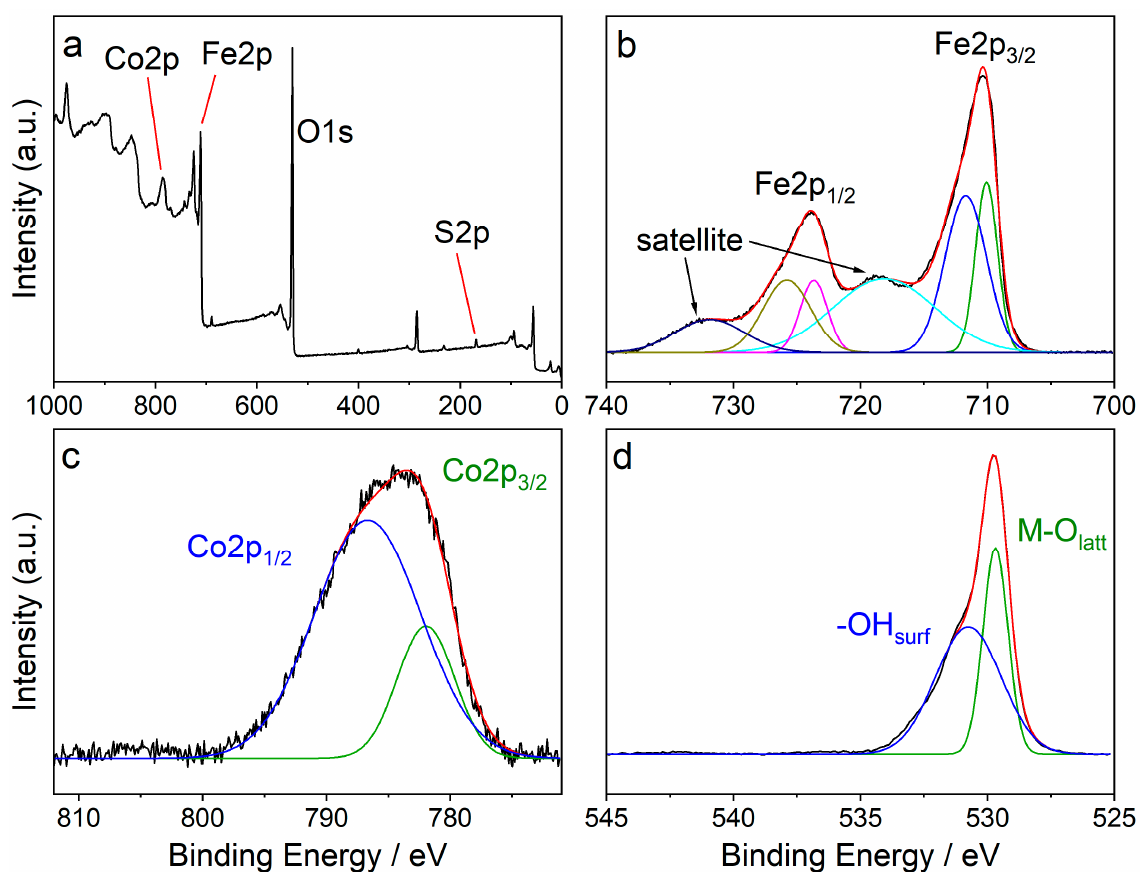
Figure 2. XPS spectra of CFO ‐ AMP in different regions ( a ) survey, ( b ) Fe2p, ( c ) Co2p, and ( d ) O1s. XPS spectra b–d are background subtracted.